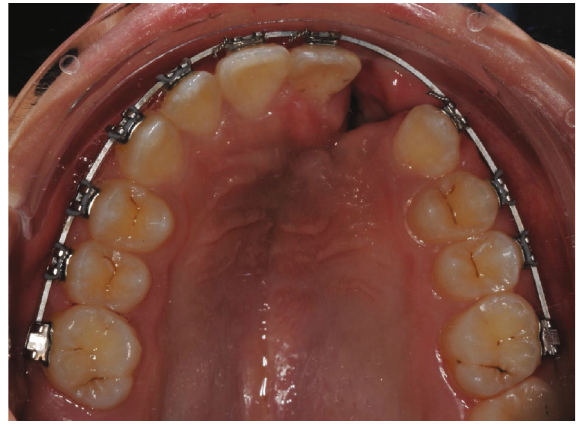
Figure 7: Tooth 22